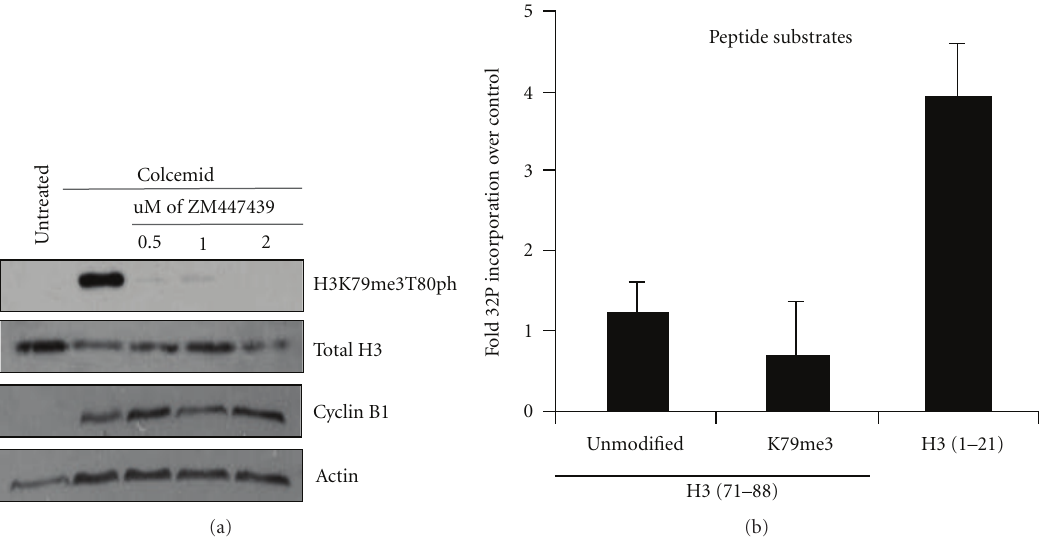
Figure 4: Aurora B is required for H3T80 phosphorylation. (a) HeLa cells were subjected to no treatment, colcemid arrest, and colcemid arrest in conjunction with ZM447439 treatment. Half of the cells were used to isolate histones and to perform an H3K79me3T80ph western blot, and half of the cells were used to make whole-cell lysate and perform a Cyclin B1 western to control for synchronization. (b) In vitro kinase assay using recombinant Aurora B/INCENP in the presence of 32 P-gamma-ATP and biotinylated H3 (1–21); H3 (71–88); H3 (71 – 88), K79me3 peptides. Bars represent fold mean 32 P scintillation counts over cold phosphorylated peptide ( ± S.E.M.), n =